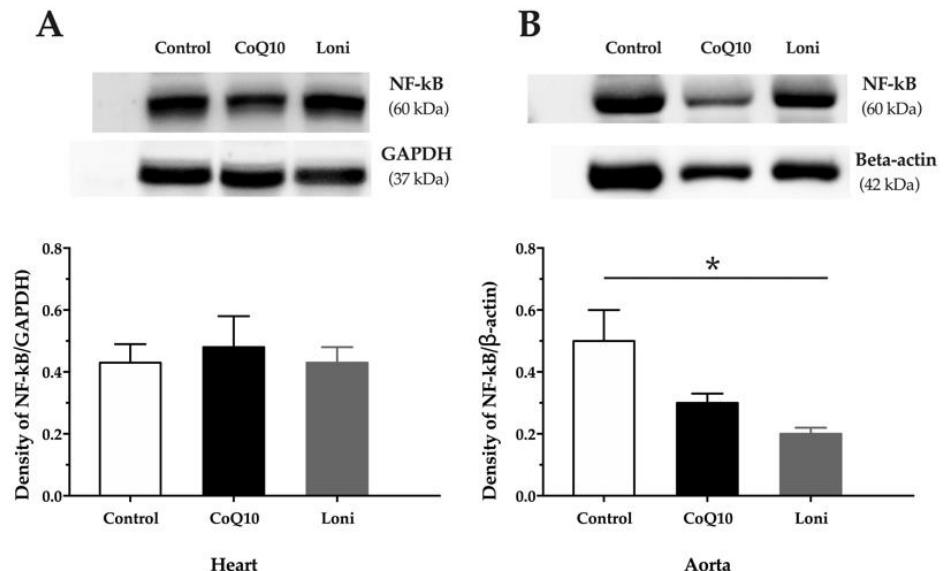
Figure 5. NF-kB protein expression in the heart ( A ) and aorta ( B ). CoQ10; coenzyme Q10, Loni; Lonicera caerulea L. Heart; F (2.15) = 0.15881, p = 0.85457; aorta; F (2.15) = 12.409, p =0.00066. * p < 0.05 compared to the control group. Data are means ± SEM from 6 animals in each group.